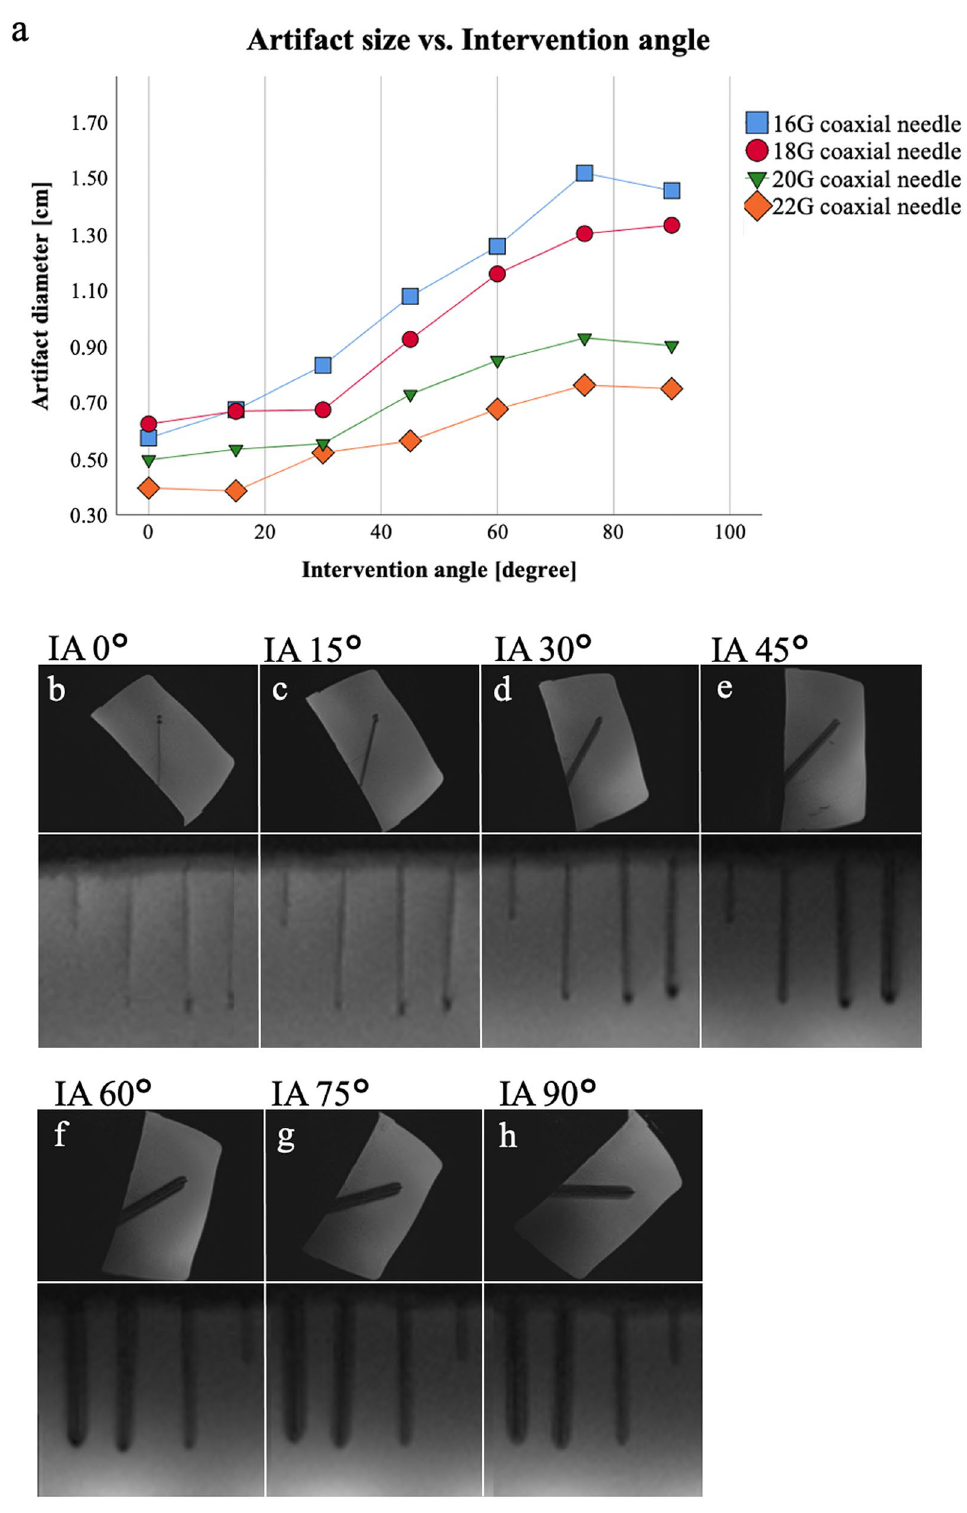
Figure 4. Scan series 6. Mean values (of both readers) of the measured artifact diameters ( a ) of the 16G, 18G, 20G, 22G needles with different intervention angles of the T1-weighted GRE sequence. Note the positive correlation of artifact diameter with intervention angle ( p ≤ 0.05) for 16G ( r = 0.980), 18G ( r = 0.966), 20G ( r = 0.960), and 22G ( r = 0.972) MR-compatible needles; in ( b – h ) the visual correlate is shown. The upper row provides demonstration purposes of the used angulation. The lower row shows the sequence images used for artifact measurements. Note the ball-like tip artifact occurring at small intervention angle (0° and 15°). IA = intervention angle, G =